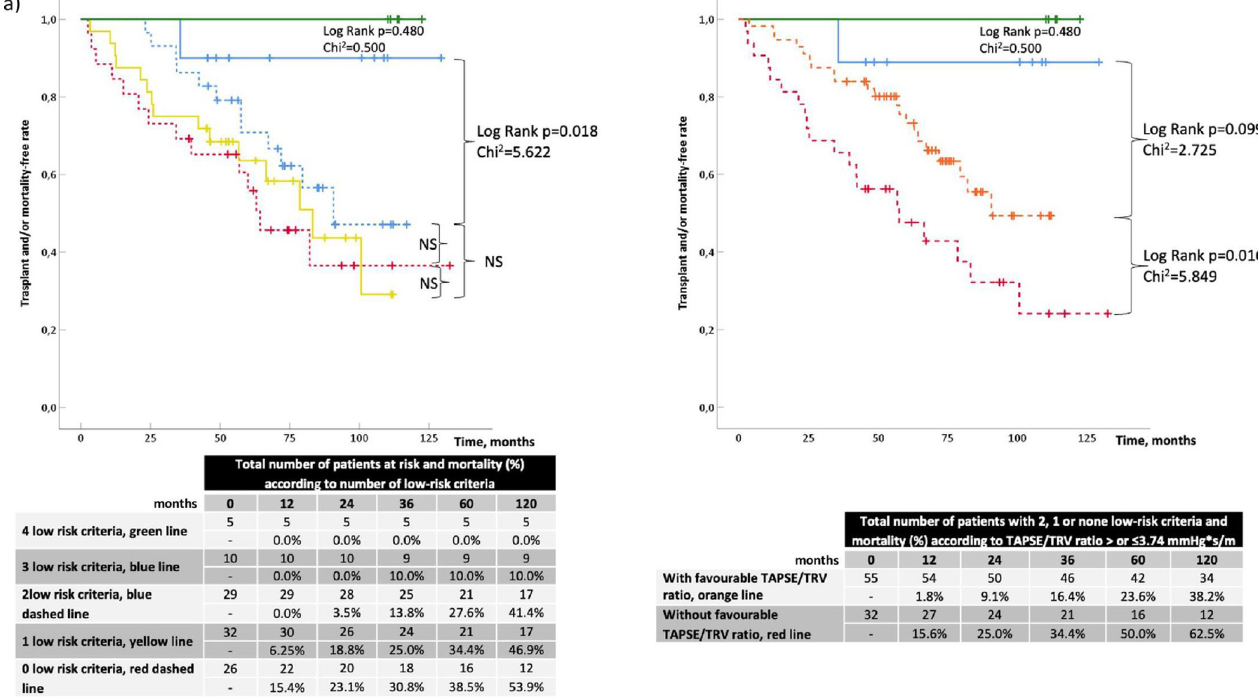
Fig 2. Kaplan-Meier curves according to PAH risk groups applying the invasive (a) and non-invasive (b) strategy of FPHN registry.